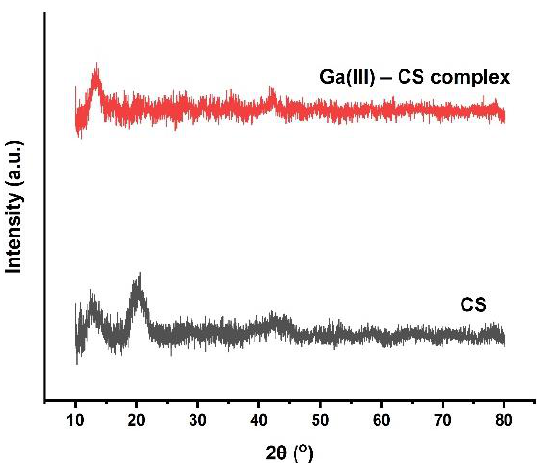
Figure 3. Comparison between XRD patterns of CS and 1:1 Ga (III)-CS complex. All other formu- lations behaved similarly. Changes in the XRD pattern with addition of Ga (III) are discussed in the text.